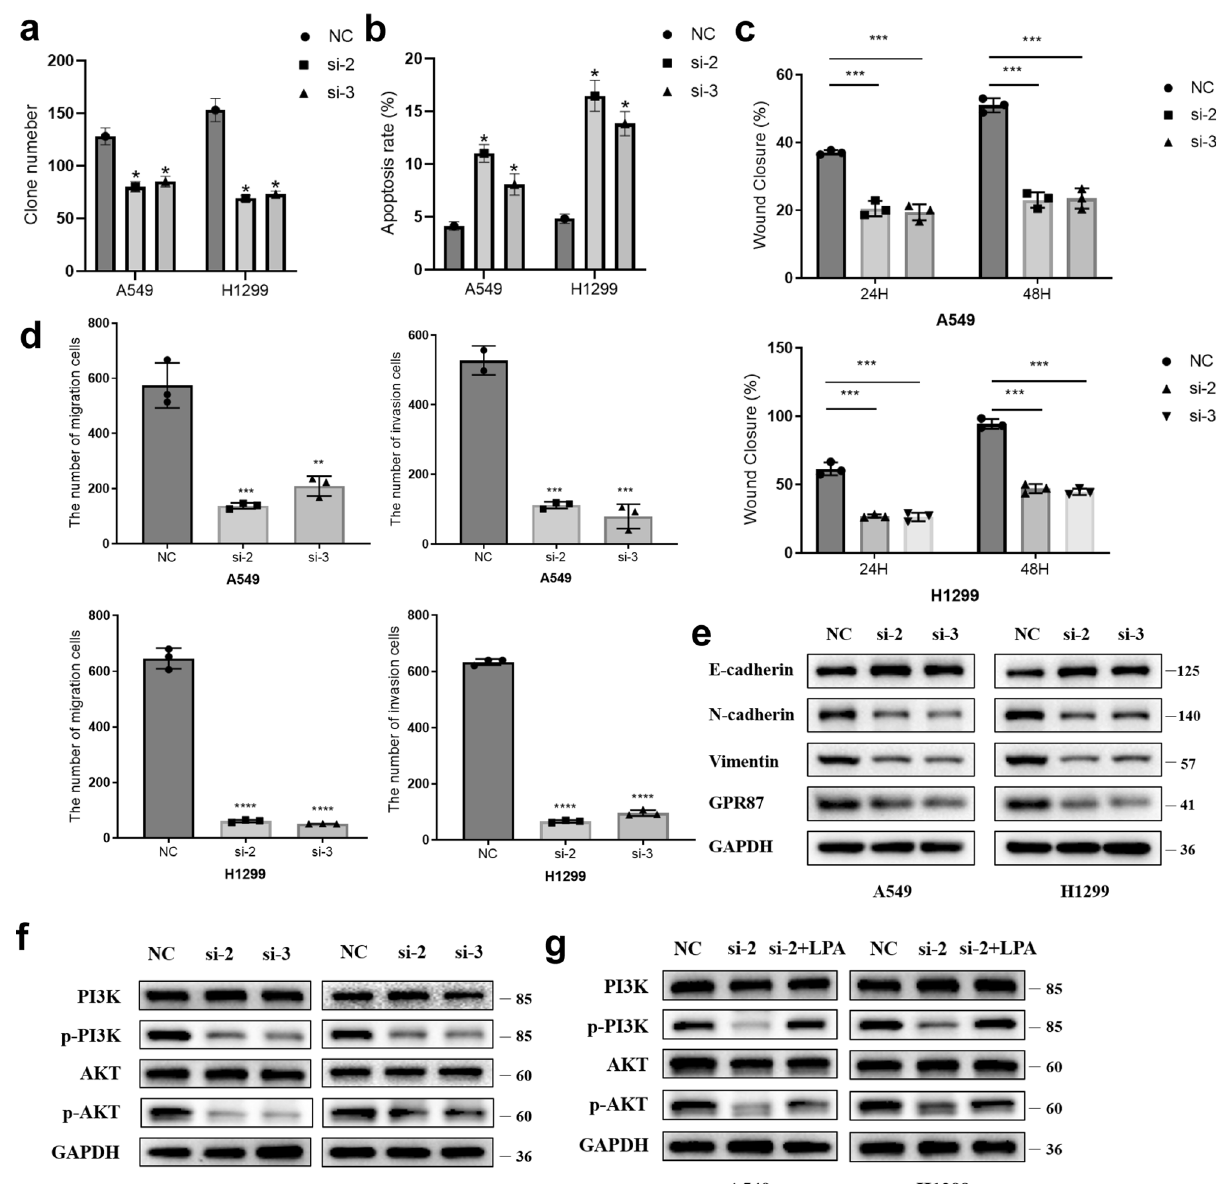
Fig. 3 GPR87 knockdown inhibits LUAD cell clonogenesis, apoptosis, and EMT. a Quantitative results of clone formation experiments. b Quantitative results of cell apoptosis experiments. c Cell migration was evaluated by wound healing assay and reduced by GPR87 knockdown. Quanti fi cation of relative wound closure. d Migration and invasion of A549 and H1299 cells transfected with GPR87 siRNA were evaluated by a modi fi ed Boyden chamber assay. Quanti fi cation of the migration and invasion cells. e Representative immunoblotting of EMT-related proteins. f Representative immunoblotting of PI3K signaling pathway-related proteins. g After the knockdown of GPR87, the LPA receptor (5 µ M) was added to the culture medium and WB assayed PI3K signaling pathway